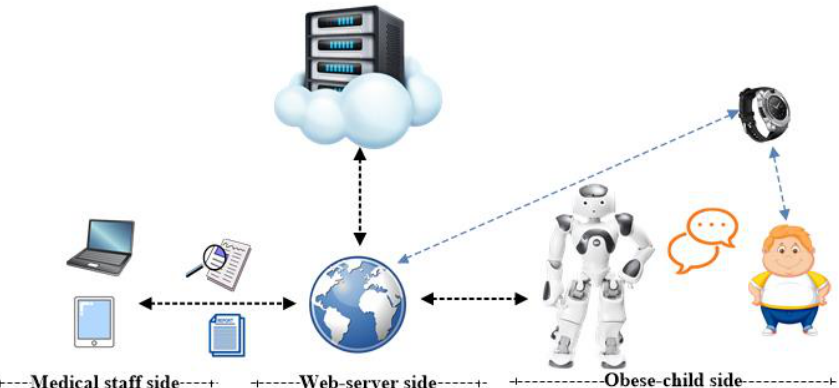
Figure 1. The obese management system concept.